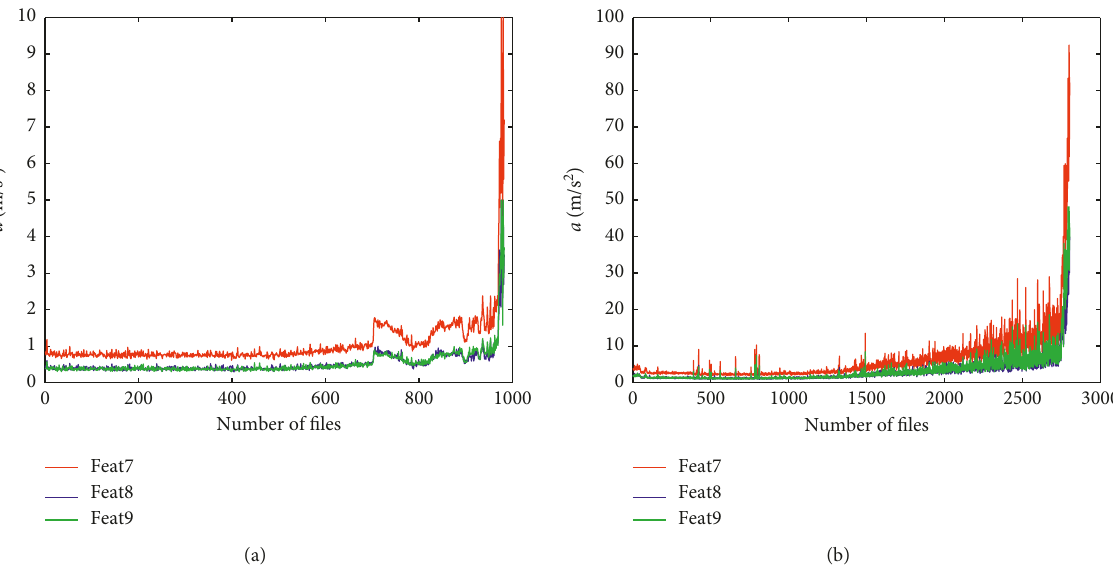
Figure 8: The peak-to-peak, maximum, and minimum values of the whole life of (a) Case I and (b) Case II.